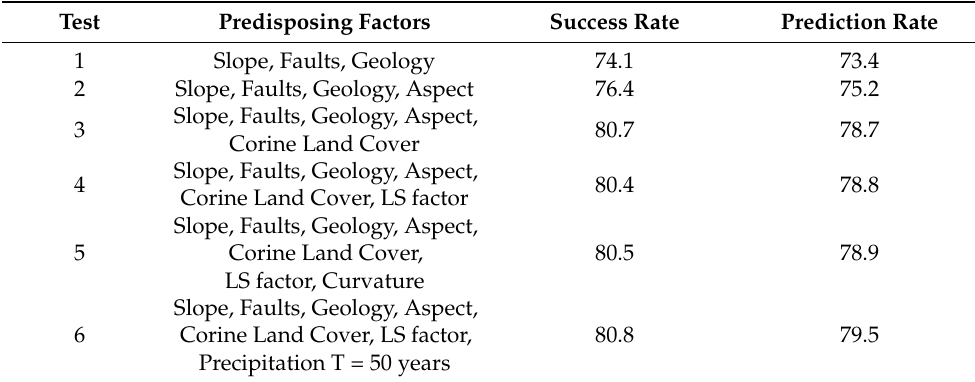
Table 2. Iteration results of Weight of Evidence modeling.